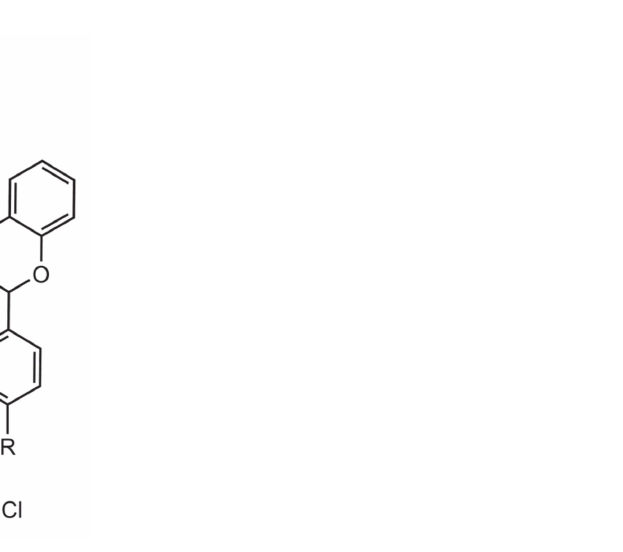
Figure 4. Structural representation of set of four ruthenium dimethylsulfoxide complexes bearing two flavonol-derived ligands.